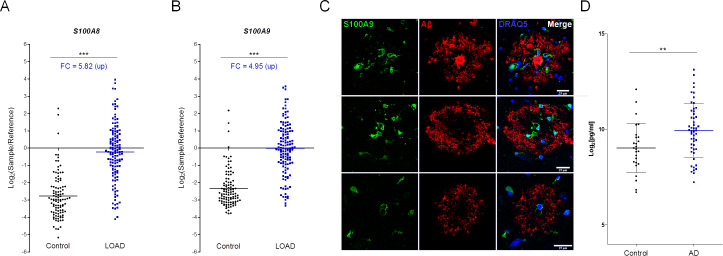
S100A8 and S100A9 are differentially expressed in LOAD.Re-examination of the expression of the orthologues of SAMP8 biomarkers in human prefrontal cortex in Control and LOAD samples from NCBI GEO GSE44770 [43]: (A) S100A8, (B) S100A9. Control: N = 101 and LOAD: N = 129 subjects. Samples are represented as Log2 (sample/reference sample). Mean ± SD are represented. Fold changes (FC) were calculated as 2^[average Log2(LOAD/Reference values)–average Log2(Control/Reference values)]. Normality was verified by D'Agostino & Pearson omnibus normality test. If data passed the normality test statistical significance was calculated by unpaired t-test, otherwise the Mann-Whitney test was applied. *p < 0.05, **p < 0.01, ***p < 0.001. (C) Double-labeling immunofluorescence and confocal microscopy of paraffin sections with S100A9 (green, left), beta-amyloid (red, middle) and merged with DRAQ5TM stained nuclei (blue, right) in temporal cortex of patients with Alzheimer’s disease. Examples of S100A9-immunoreactive microglia localized in the vicinity of β-amyloid plaques. Bar = 25 μm. (D) S100A8/A9 levels in CSF samples from AD patients (N = 51) and healthy controls (N = 26), as determined by S100A8/A9 ELISA. Data are expressed as Log2 of the S100A8/A9 heterodimer concentration in pg/ml. Each dot represents one CSF donor and mean ± SD of each group are shown. Fold Change was calculated as the ratio of the average S100A8/A9 concentrations of the AD and control sample groups: average ([S100A8/A9 pg/ml]AD SAMPLES)/average([S100A8/A9 pg/ml]CONTROL SAMPLES). Normality was verified by D'Agostino & Pearson omnibus normality test and statistical significance was calculated by unpaired t-test (t(75) = 2.810; p = 0.0063). **p < 0.01.